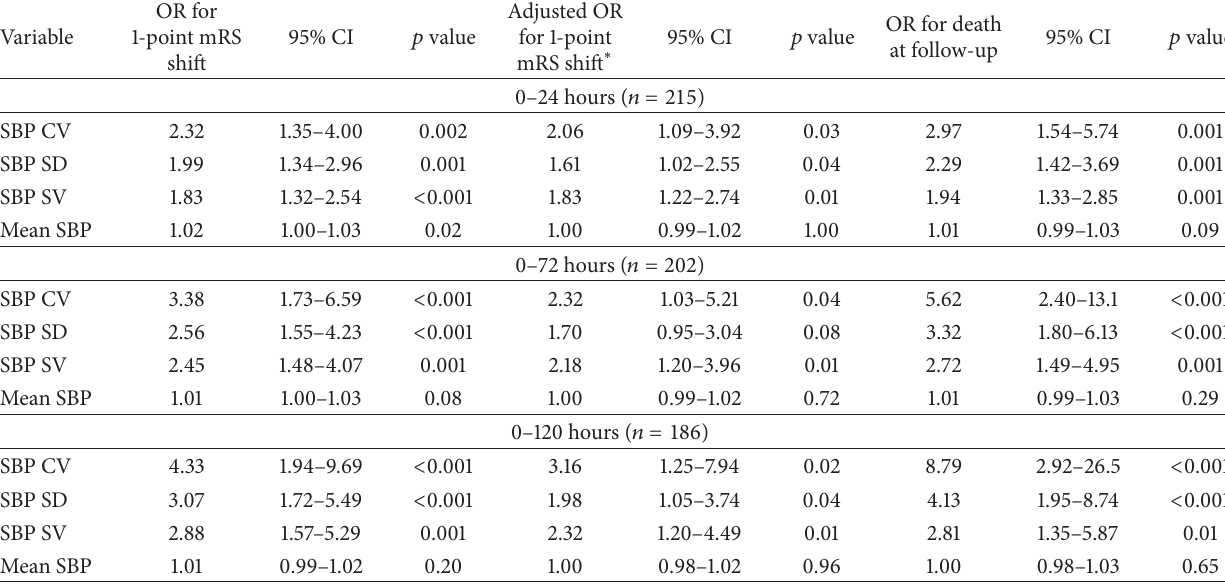
Table 3: Ordinal logistic regression models with predictor variables of systolic BPV and mean SBP fitted to the outcomes; (a) columns 2–4: one-point shift in mRS, (b) columns 5–7: bad outcome (mRS 3–6), and (c) columns 8–10: